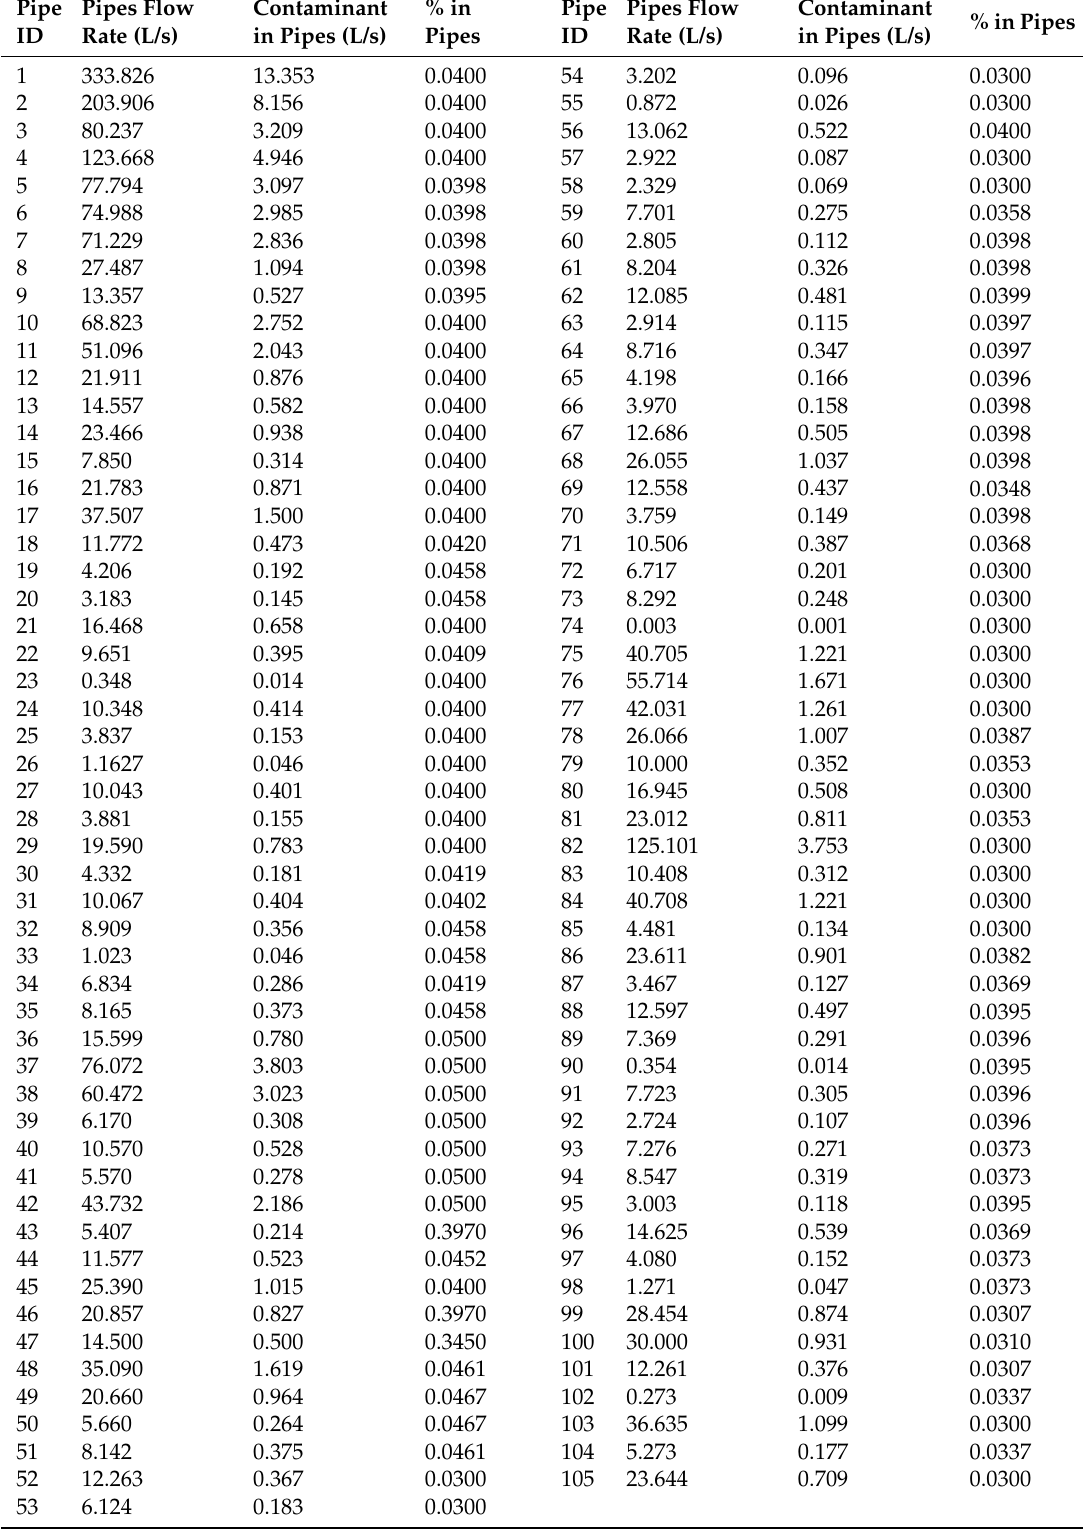
Table 6. Numerical results for pipe and contaminant flow for Illustrative Example